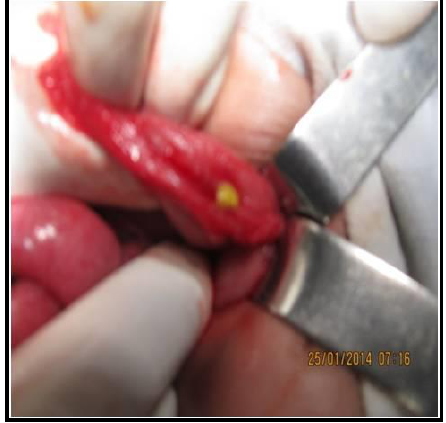
Figure 1: Intra-operative image of the single per- foration in the transverse